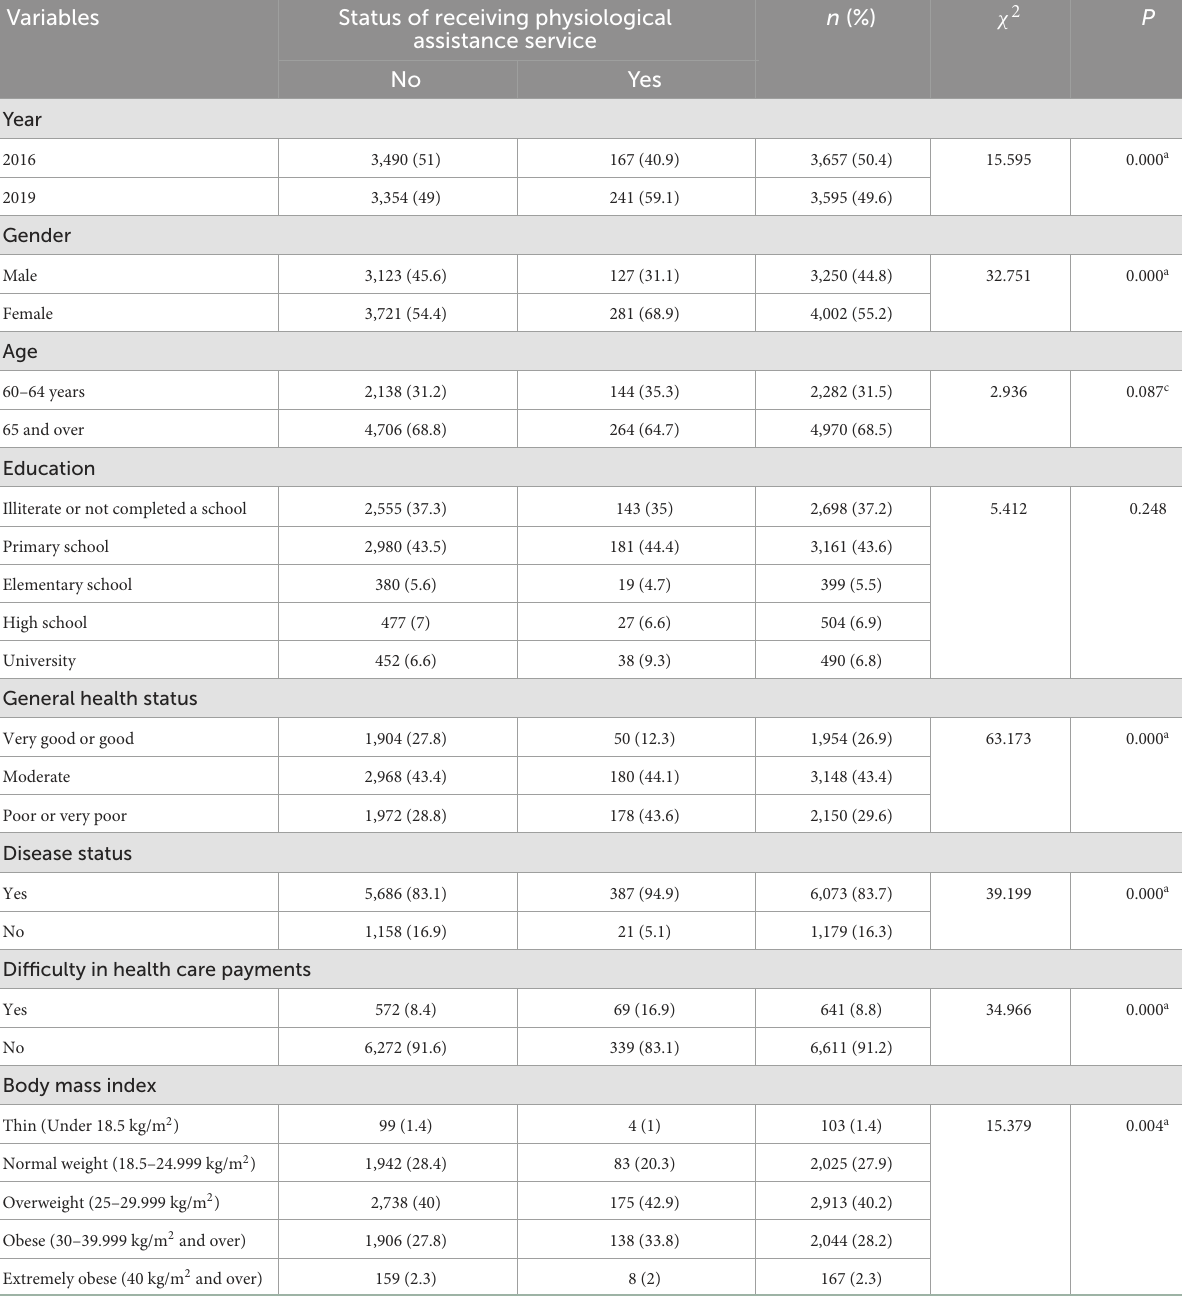
TABLE 1 Prevalence of factors affecting older individuals’ receiving psychological assistance services and chi-square test statistics.